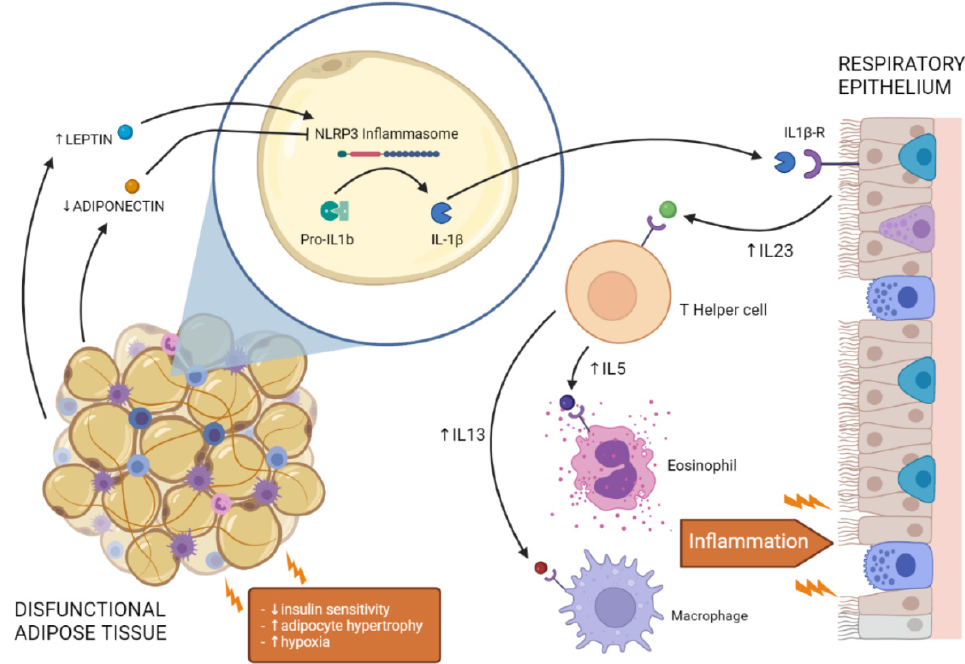
Figure 1. Crosstalk between dysfunctional adipose tissue and respiratory epithelium in the lung. Insulin resistance, adipocyte hypertrophy, and hypoxia alter adipokine secretion from dysfunctional adipose tissue, promoting NLRP3 inflammasome activation and IL-1 β secretion. Activation of IL-1 β signalling in the lung increases the expression of pro-inflammatory cytokines (e.g., IL-23, IL-5, IL-13), promoting the activity of immune cells (e.g., T-helper cells, eosinophils, macrophages) and leading to lung inflammation.